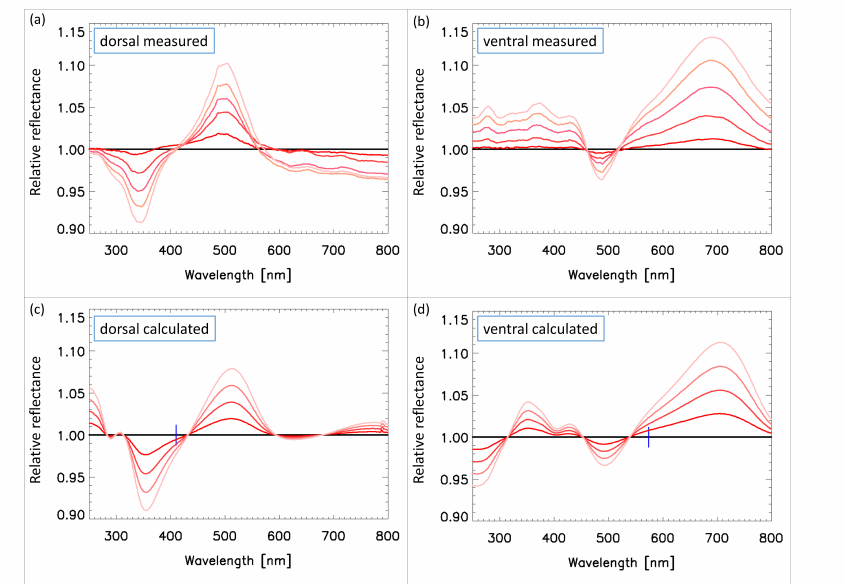
Figure 7. Comparison of the measured and calculated vapor-dependent dorsal and ventral relative reflectance spectra of the Albulina metallica butterfly. ( a , b ) Measured spectra for 10%, 20%, 30%, 40%, and 50% ethanol vapor concentrations. ( c , d ) Calculated spectra for 12.5%, 25.0%, 37.5%, and 50.0% ethanol vapor